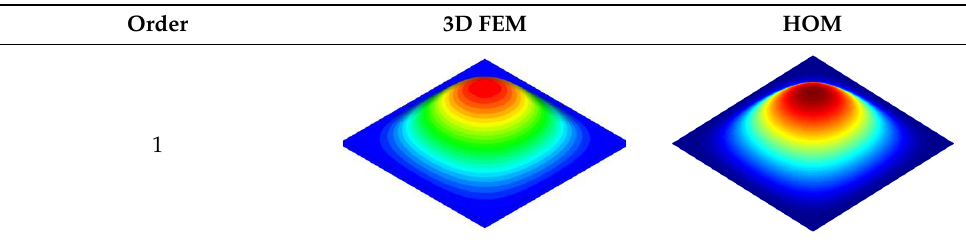
Table 1. First five-order natural frequencies of the CCCC single-layer periodic plate.